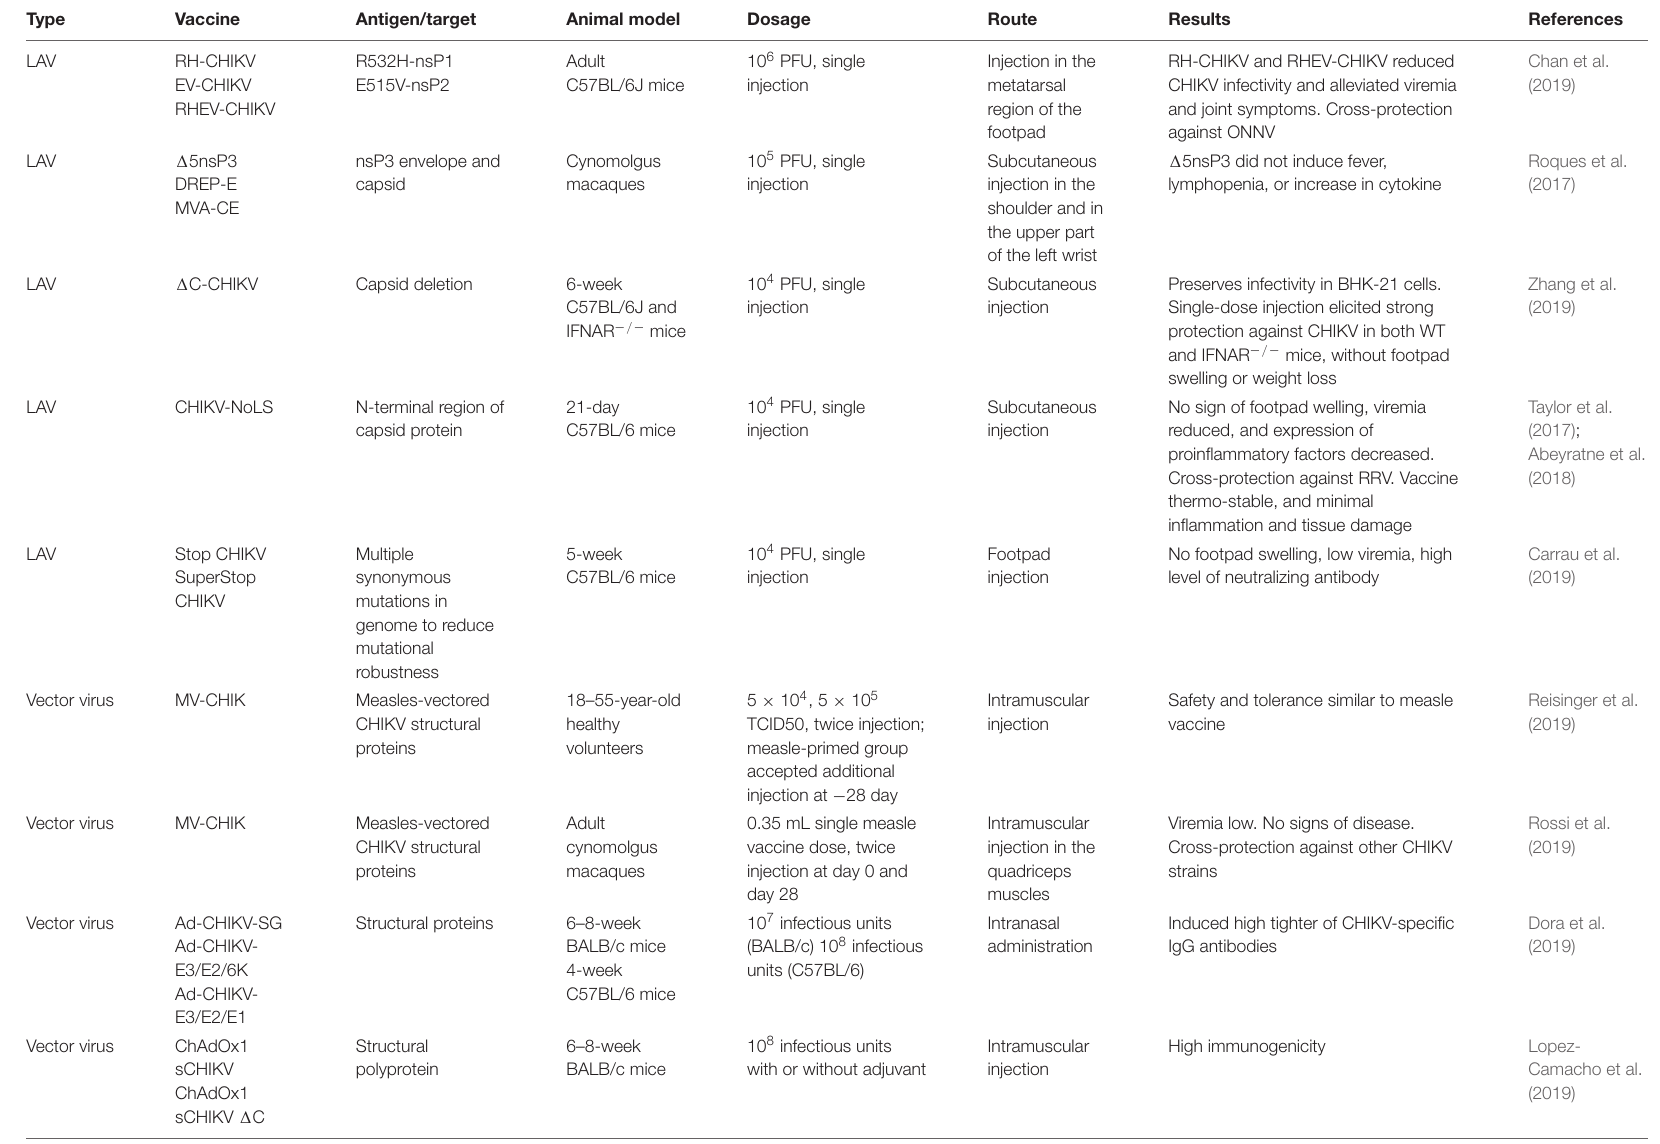
TABLE 1 | Recently developed vaccine candidates against